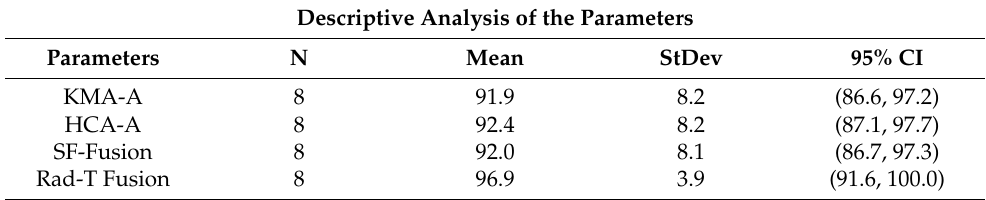
Table 7. Descriptive analysis of KMA-A, HCA-A, SF-Fusion, and Rad-T Fusion average values. Descriptive Analysis of the